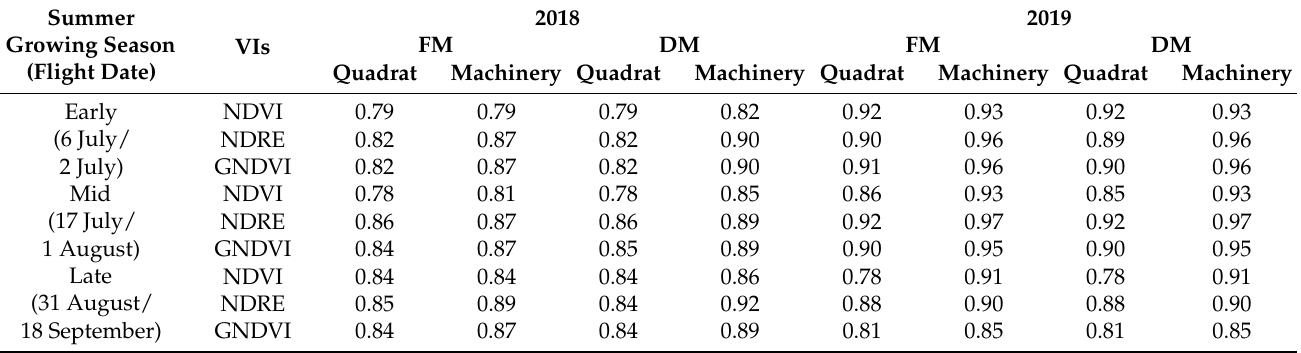
Table 7. R 2 between fresh (FM, Mg ha − 1 ) and dry matter (DM, Mg ha − 1 ) of Miscanthus , as well as corresponding vegetation Indices (NDVI, NDRE, GNDVI) from quadrat areas ( n = 64) and machine- harvested areas ( n = 32) obtained from unmanned aerial vehicle images collected over three flights in 2018 and 2019.